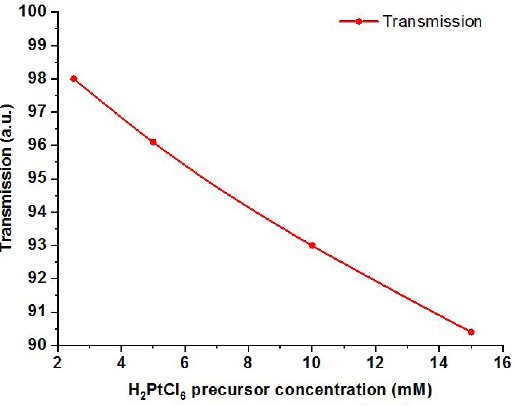
Figure 10. Transparence properties of Pt/ FTO thin